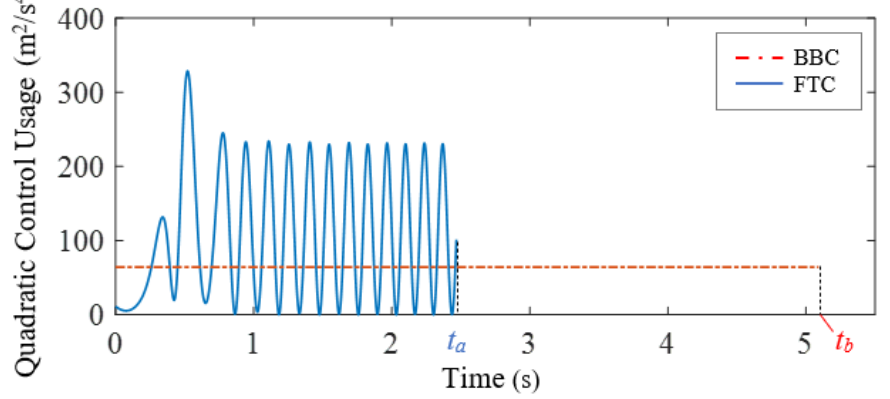
Figure 11. Case study 3: the comparison of the FTC and BBC quadratic control usage. Table 1. Case study 3: the comparison of FTC and BBC